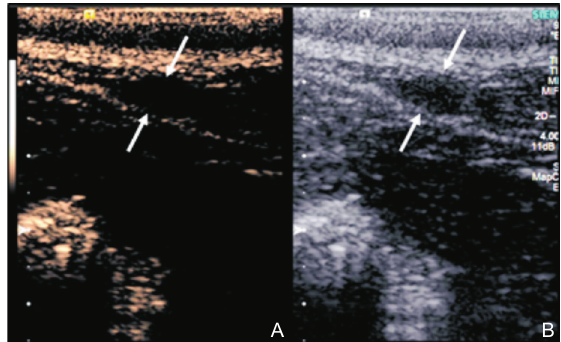
Figure 7 Benign lymph node (arrows) in swine model. (A) Contrast enhanced ultrasound image shows no retention of targeted microbubbles in the node; (B) B-mode ultrasound demonstrates homogenous lymph node, likely representing a normal lymph